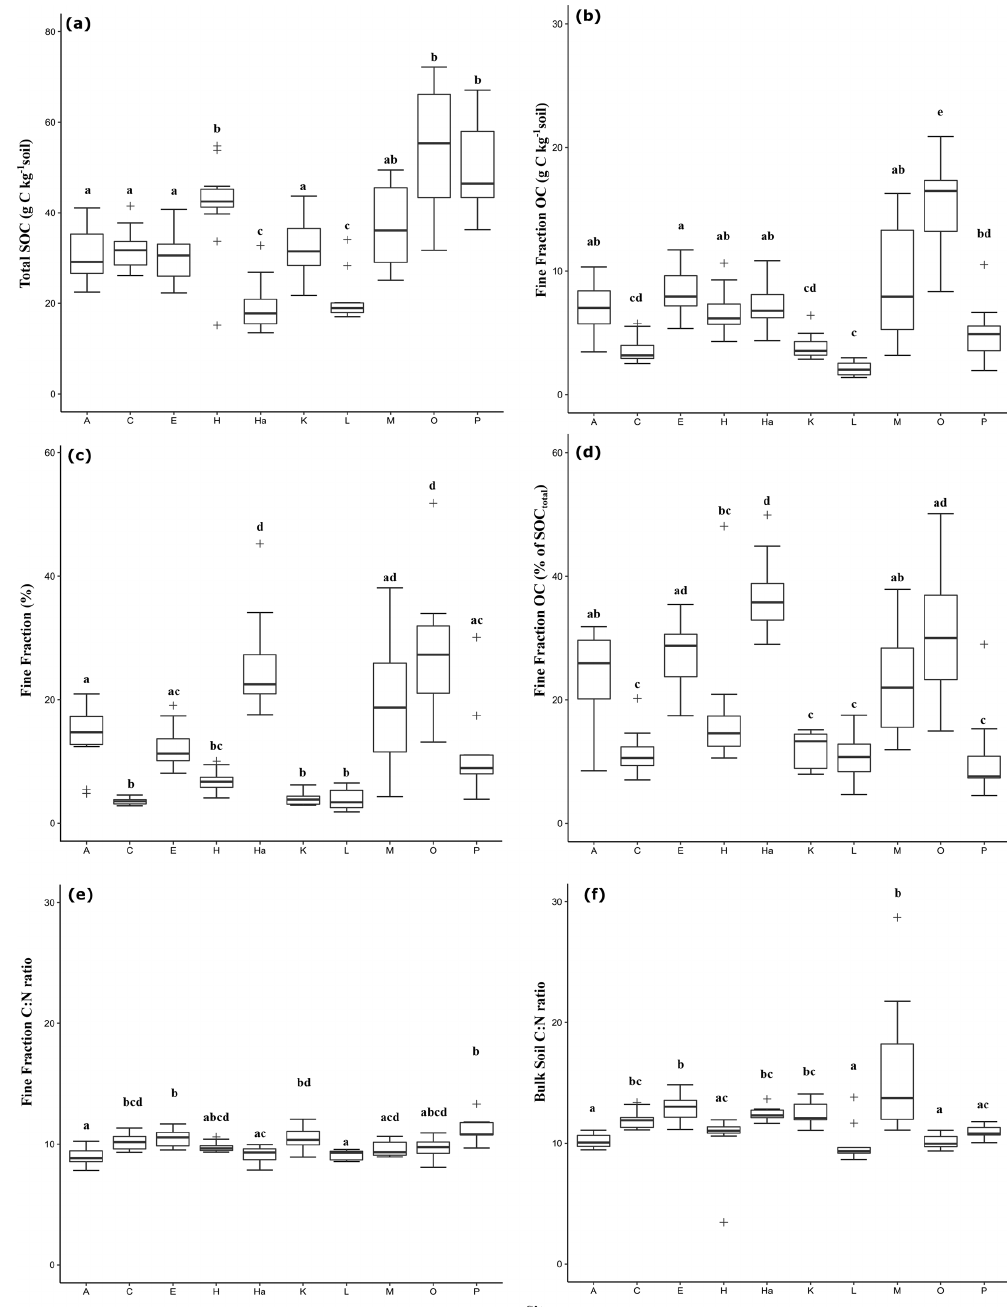
Figure 1. Measured total SOC (gC per kg soil) (a) , total fine-fraction organic carbon (gC per kg soil) (b) , mass proportion of the fine fraction ( < 20µm, %) (c) , relative proportion of measured fine-fraction organic carbon of the total SOC content of the bulk soil (d) , fine-fraction C : N ratio (e) and bulk-soil C : N ratio (f) for each of the grassland sites: Aberystwyth (A), Crichton (C), Easter Bush (E), Hillsborough (H), Harpenden (Ha), Kirkton (K), Llangorse (L), Myerscough (M), Overton (O) and Plumpton (P). Boxes represent the 25th and 75th percentile, with lines showing the median value. Whiskers show the lowest and highest values with outliers indicated as crosses ( > 1.5 times the interquartile range). Lettering indicates significant differences between soils ( p < 0 .